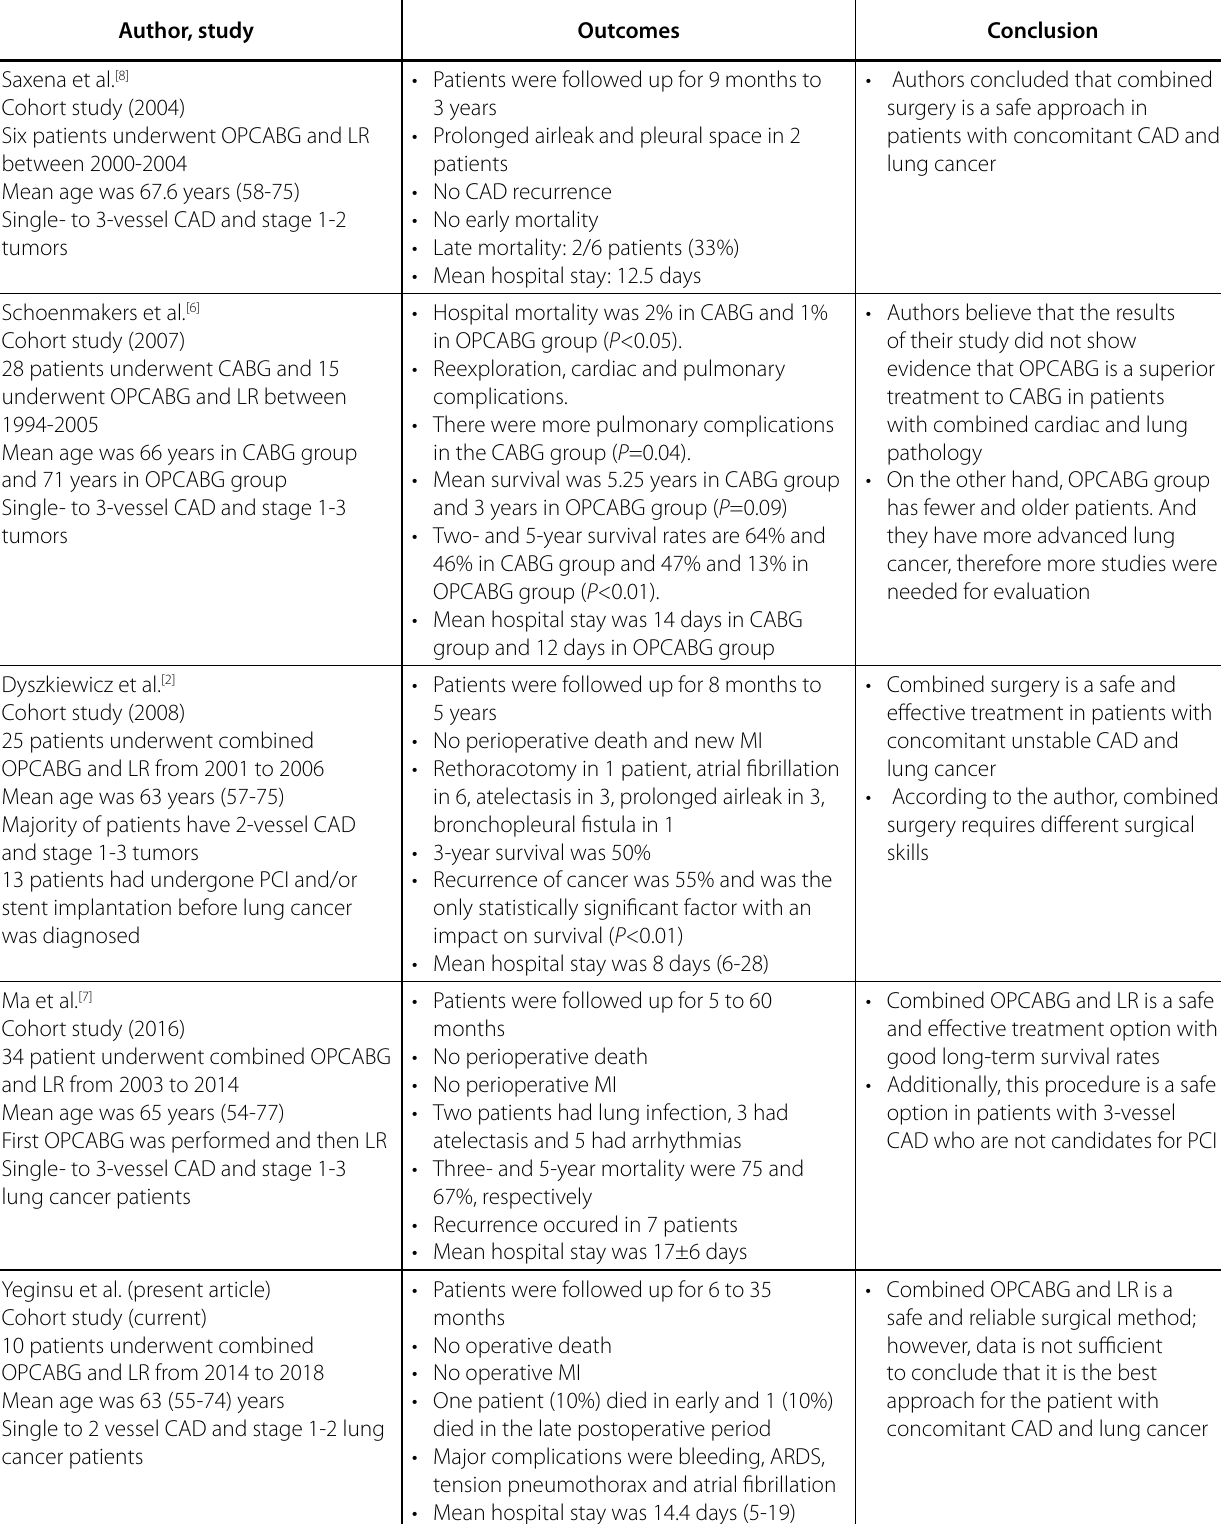
Table 5 . Outcomes of simultaneous OPCABG and lung tumor resection in the